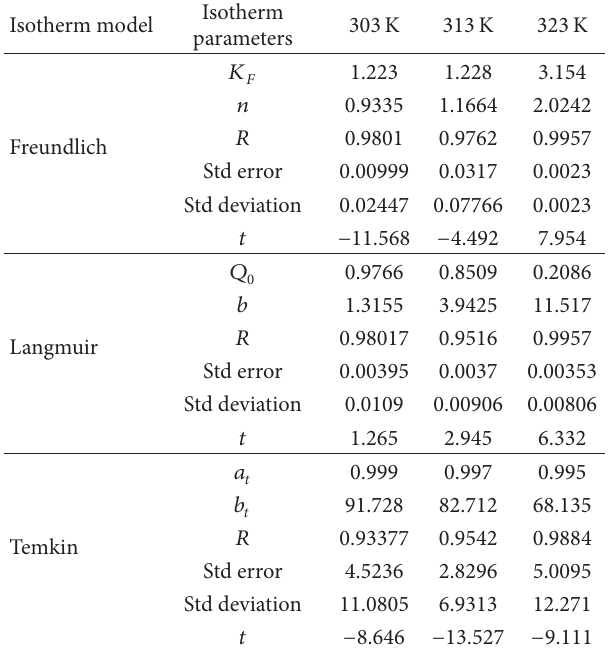
T 2: Adsorption isotherm and statistical comparison values of adsorption isotherm.